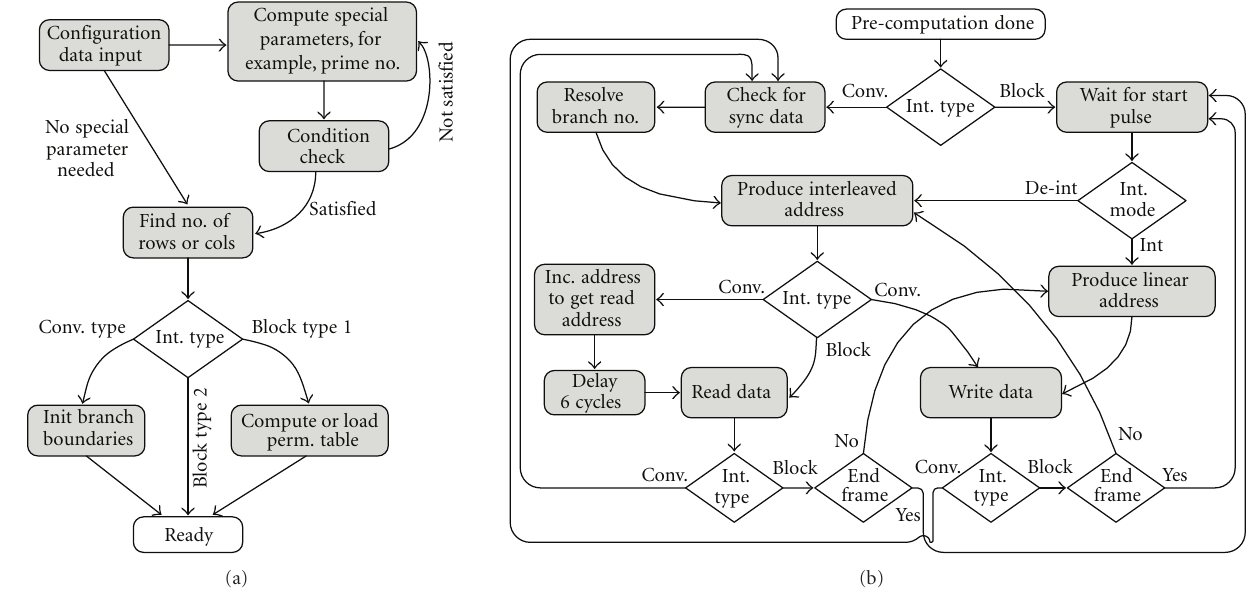
Figure 2: Data flow graph for (a) precomputation phase (b) execution phase.